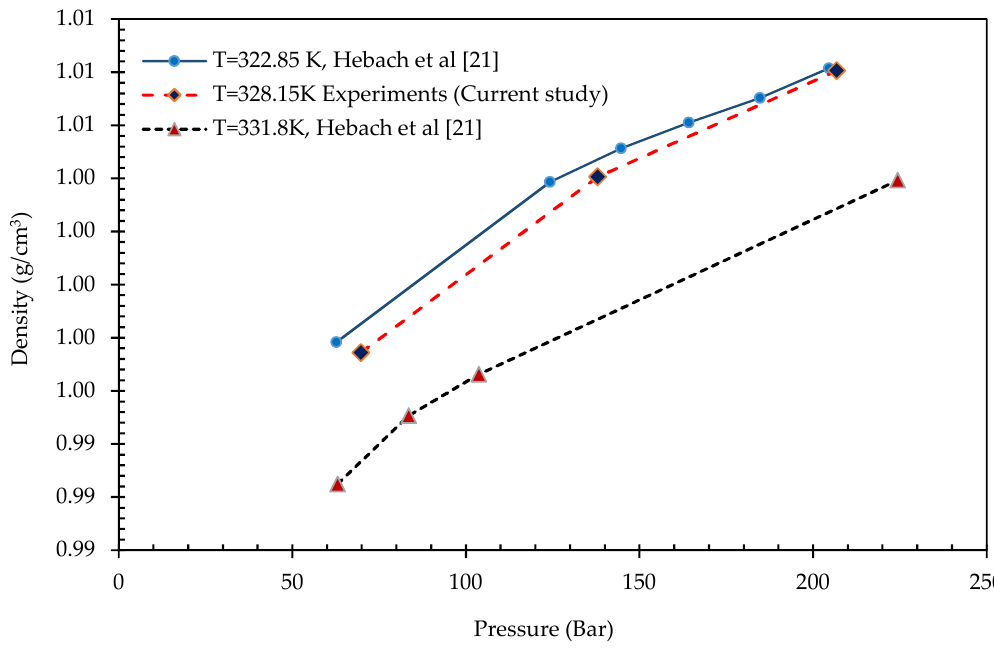
Figure 4. Comparison of experimental measurements of density of pure H 2 O saturated with CO 2 versus pressure from current study with data reported by Hebach et al. [21].